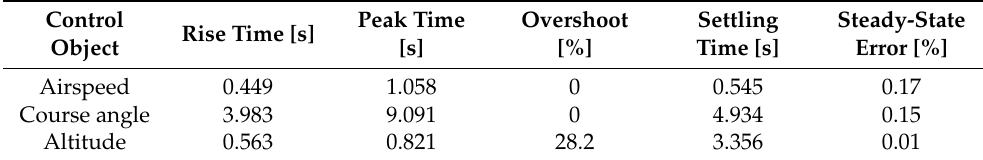
Table 7. Transient step response parameters for the stability controller.